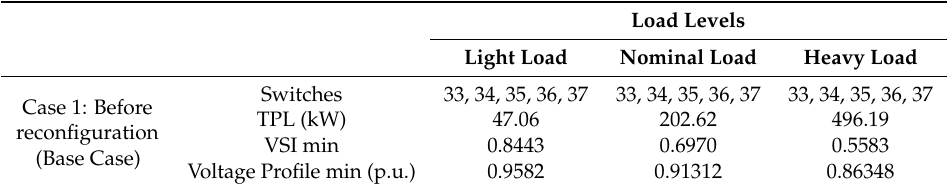
Table 2. Base case at different load conditions for 33-bus system.